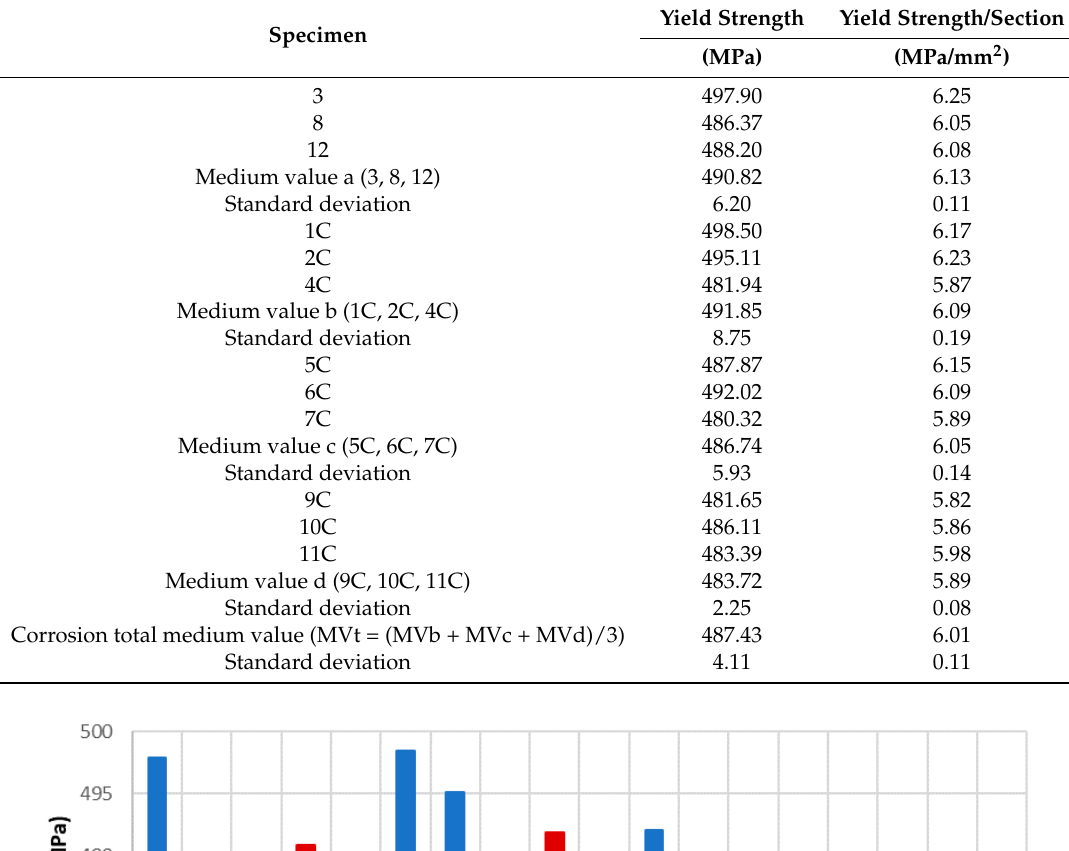
Table 4. Yield strength and yield strength/section relation values per specimen and Medium values.